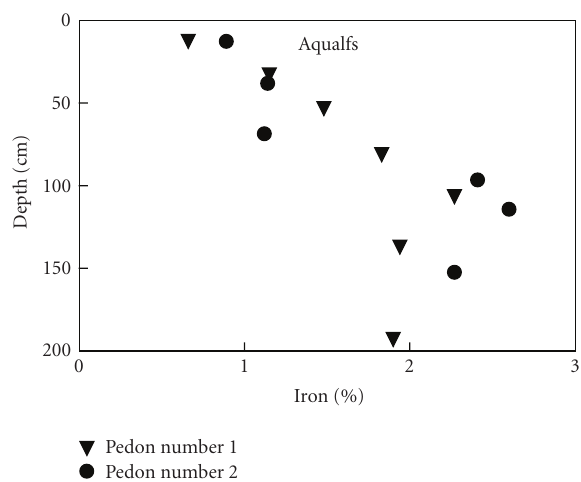
Figure 1: Soil profile Fe depth distribution for the Aqualf pedons.